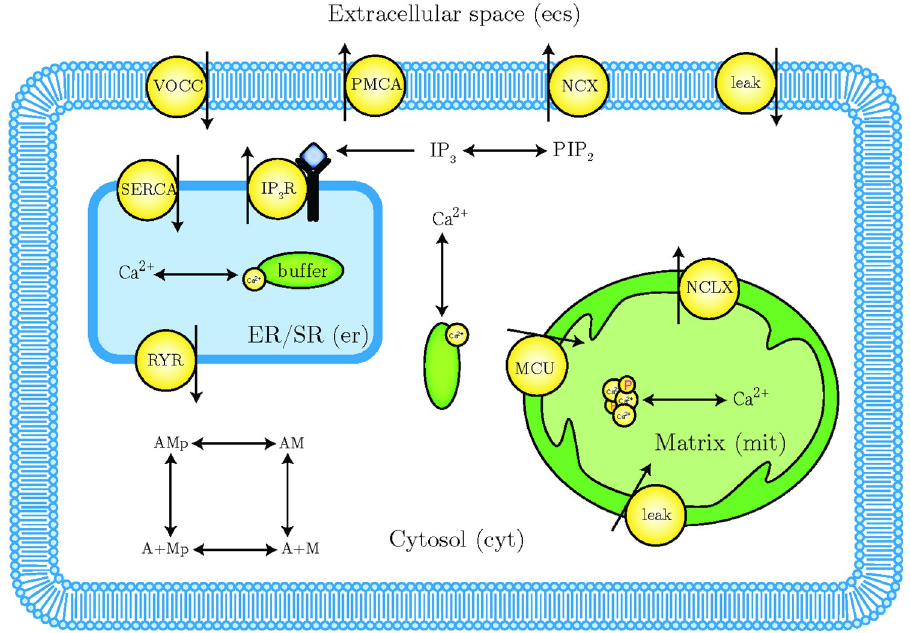
Fig 1. Model schematic showing compartments, calcium exchanges, and other reactions specifically considered. Note that only calcium ions are considered in our model so we ignore counter-transporters such as sodium. Most of the exchange mechanisms are bidirectional—direction that is relevant to the scope of our model is